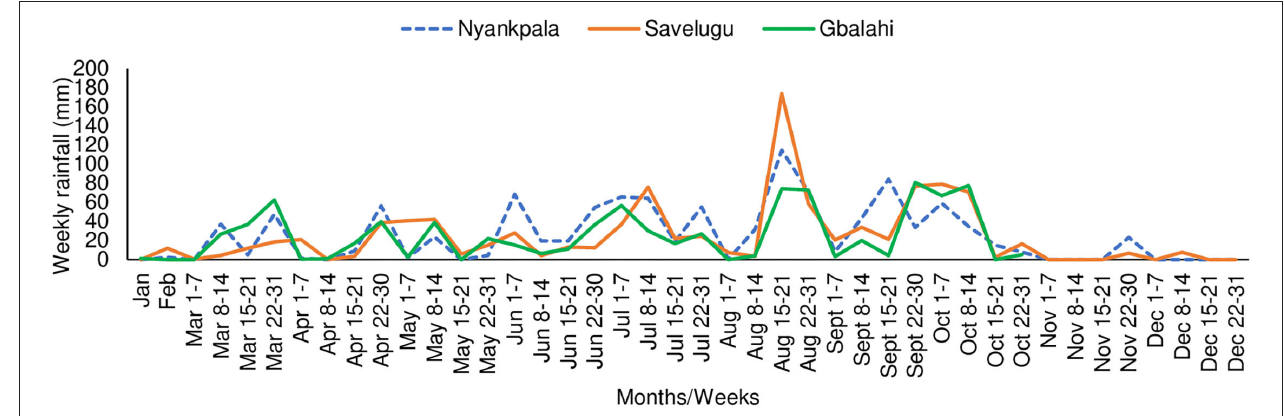
FIGURE 1 | Weekly rainfall distribution at Nyankpala, Savelugu, and Tamale (Gbalahi) during the study in 2013.